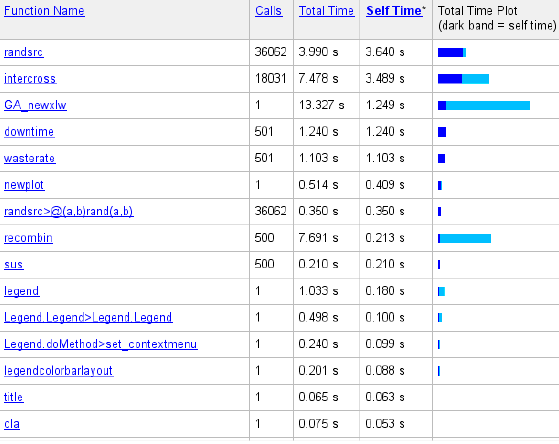
Figure 6. Running time graph.